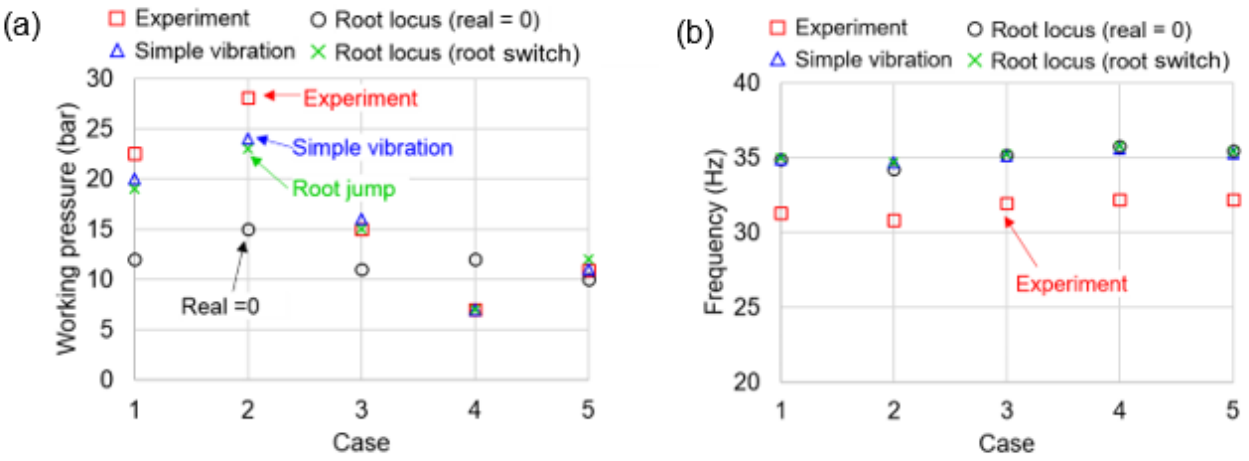
Figure 11. Comparison of experiments with two dynamic model predictions for all the cases 1–5: ( a ) mid-point operable charge pressure and ( b ) operating frequency. Table 4. Comparison of experiments with two dynamic model predictions for all the cases 1–5: mid-point operable charge pressure.